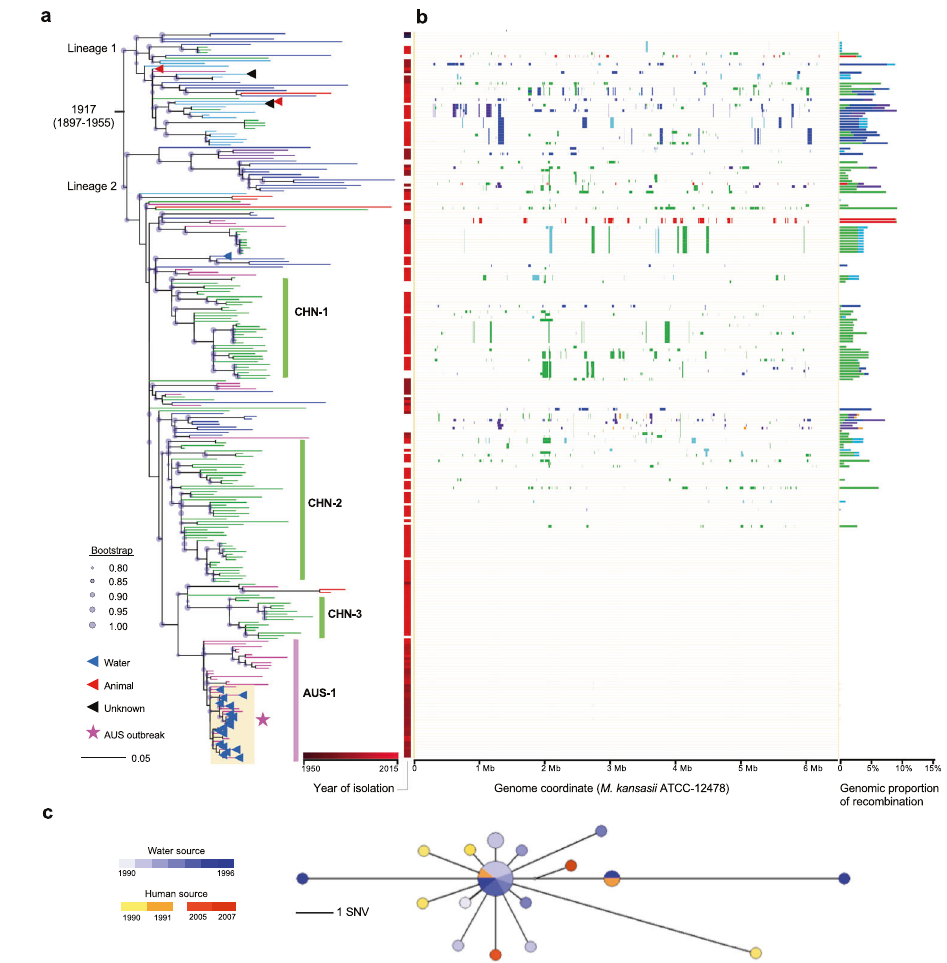
Fig. 3 Phylogenomic analyses of the M. kansasii main cluster (MKMC). a The maximum-likelihood phylogeny of the MKMC based on non-recombinant mutations. The colors of terminal branches indicate the geographical origins of the isolates, as in Fig. 1a. Isolation from non-human or unknown sources is indicated by triangles in the terminal nodes. b Genomic pattern and proportion of recent recombinations for individual isolates. Donor species are colored as in Fig. 2a. Source data are provided as a Source Data fi le. c Median-joining network for the Australia outbreak strain cluster. Node size indicates the number of isolates; node color indicates the source and year of